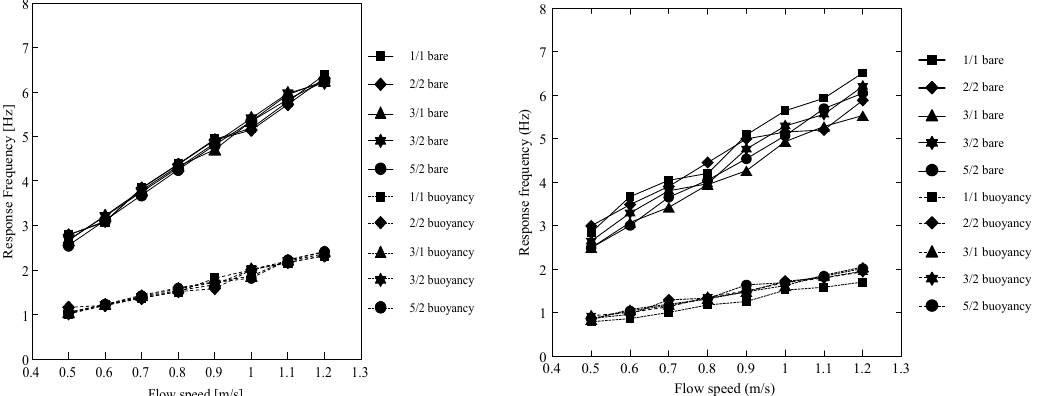
Figure 15. Excited response frequencies for five configurations at flow speeds between 0.5 m/s–1.2 m/s. ( Left ): prediction using the derived excitation coefficients from VIVANA; ( Right ): measured response frequencies from Shell Test.